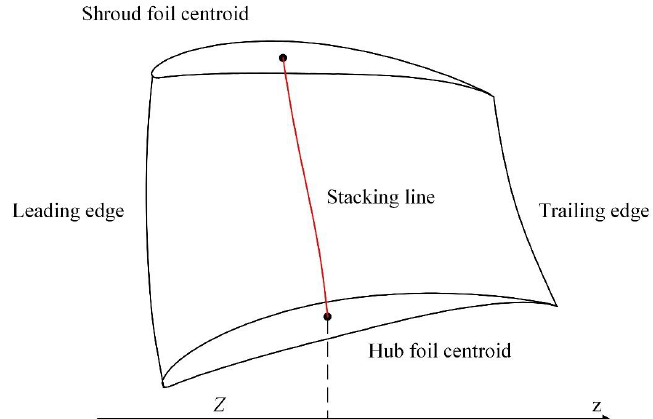
Figure 7. Foil stacking line.